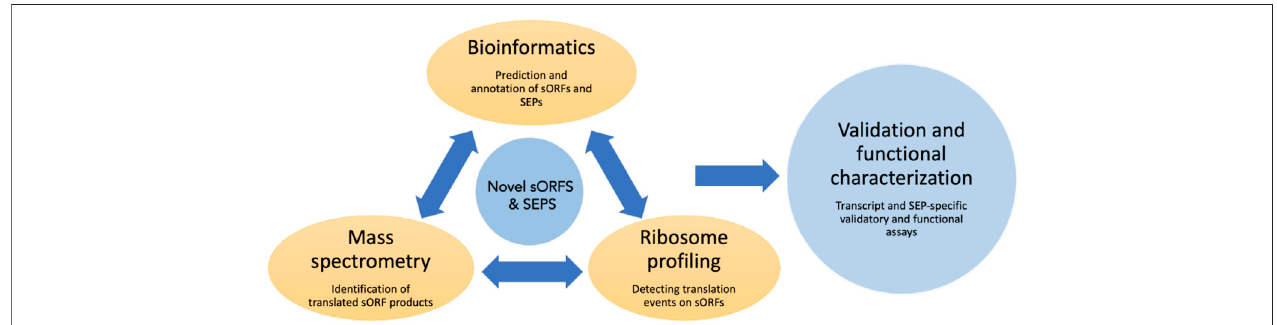
FIGURE 2 | Overview of the commonly used techniques to identify and characterize sORFs and their encoded peptides. Novel sORFs and their products can be detectedbythepredictionalgorithmsusingbioinformaticapproaches,bygeneratingpeptidedatabasesusingimprovedmassspectrometry-basedassaysandbyusing ribosome pro fi ling and related sequencing techniques to obtain translationally active transcripts. The predicted SEPs can be validated by various assays such as reporter-based overexpression, epitope tagging etc. Loss of function assays could be done to assess the cellular function of these SEPs.